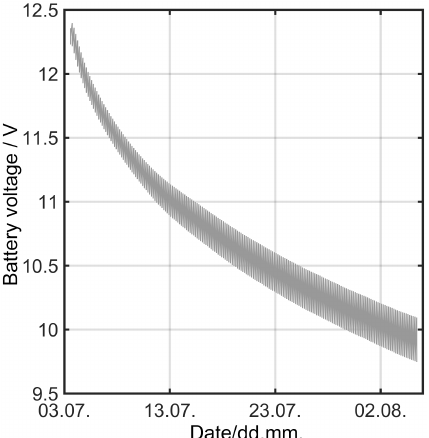
Figure 4. Battery voltage over the time of the second deployment in July/August 2010 (grey line). The voltage drops during profiling and recovers during the 4h sleep